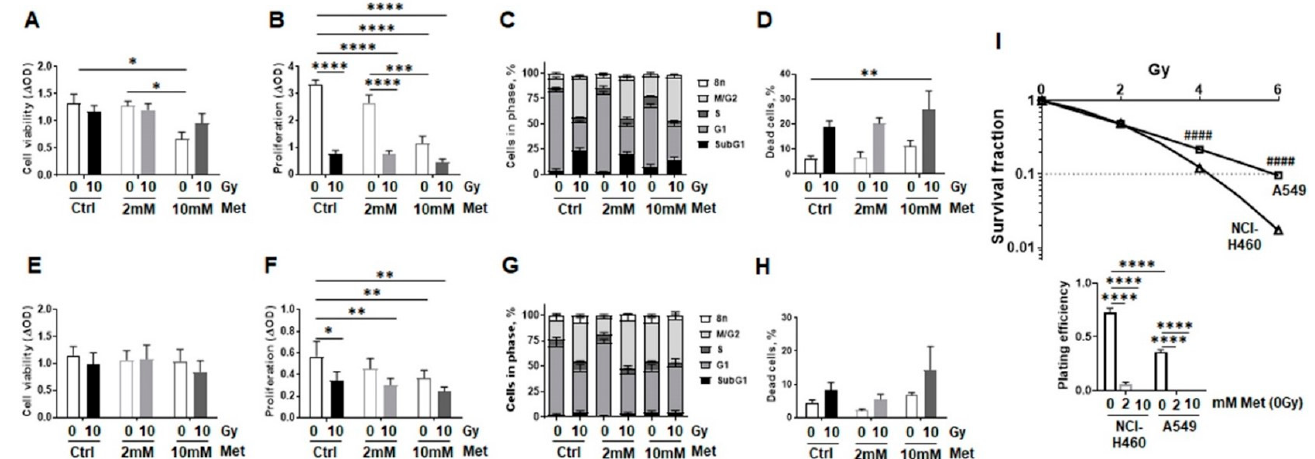
Figure 8. Metformin treatment reduces malignant lung epithelial cell proliferation and survival following RT. Non-small cell lung cancer cells (NSCLC; NCI-H460: human epithelial large cell lung carcinoma; ( A – D ) and A549: human alveolar basal epithelial adenocarcinoma; ( E – H )) were cultured in normal growth media supplemented with metformin (2 and 10 mM) or vehicle control (Ctrl) 2 h prior radiation treatment with 0Gy or 10Gy. Cell viability ( A , E ) cellular proliferation ( B , F ), cell cycle distributions ( C , G ), and cell death induction ( D , H ) were analyzed 96 h after the treatments. ( A , E ) Cell viability measurements as determined by metabolic activity using the WST-1 reagent are summarized as mean values ±SEM of 4 – 5 experiments, with seven replicates each. ( B , F ) Cellular proliferation was analyzed by crystal violet staining. Data are presented as mean values ±SEM of 5 independent experiments. p -values indicate * p ≤ 0.05, ** p ≤ 0.01, *** p ≤ 0.001, **** p ≤ 0.0001 by two-way ANOVA with Tukey’s multiple comparison test. ( C , G ) Respective cell cycle analysis at that time point were estimated following Nicoletti staining. Data were summarized as mean values ±SEM of 5–7 independent experiments. ( D , H ) Total cell death levels were determined by propidium iodide exclusion staining using flow cytometry. Data are summarized as mean values of 3–5 independent experiments. p -value indicate ** p ≤ 0.01 by two-way ANOVA with Tukey’s multiple comparison test. ( I ) Clonogenic survival was evaluated in metformin treated (0, 2, 10 mM) and irradiated (0, 2, 4, 6 Gy) NCI-H460 and A549 cells, 10 days post treatment. Coomassie stained colonies were quantified and respective surviving fractions from 3 independent experiments (means ±SEM), plated in triplicates each, were depicted. As metformin treatment dramatically reduced the plating efficiency of both NSCLC cells in a concentration-dependent manner, no colonies could be quantified here. Statistics were analyzed by unpaired (two-tailed) t-tests, comparing NCI-H460 cells to corresponding A549 cells.